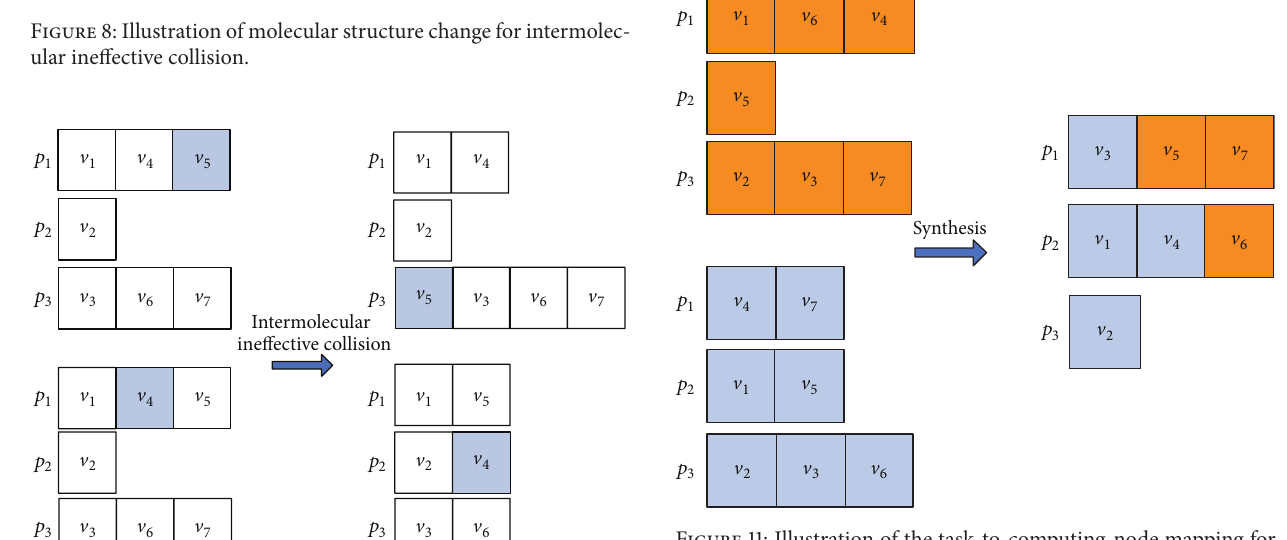
Figure 11: Illustration of the task-to-computing-node mapping for